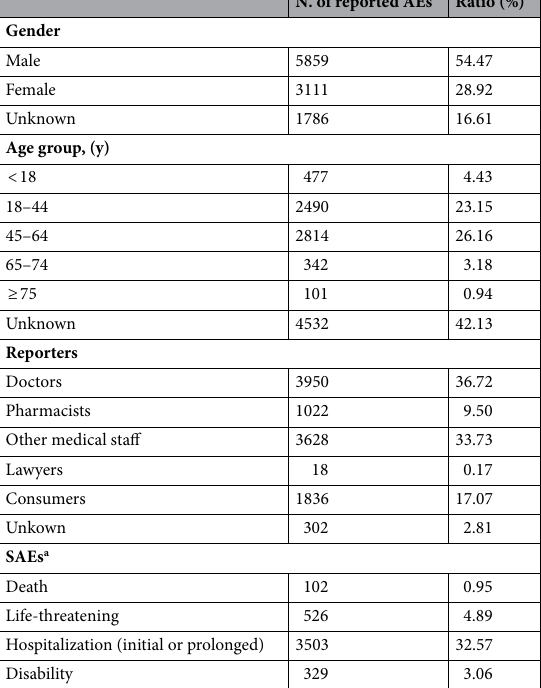
(Table 5). When detected separately, signals of abortion spontaneous and foetal growth restriction for darunavir/ cobicistat were positive, and premature baby for darunavir/ritonavir positive (Table 6).